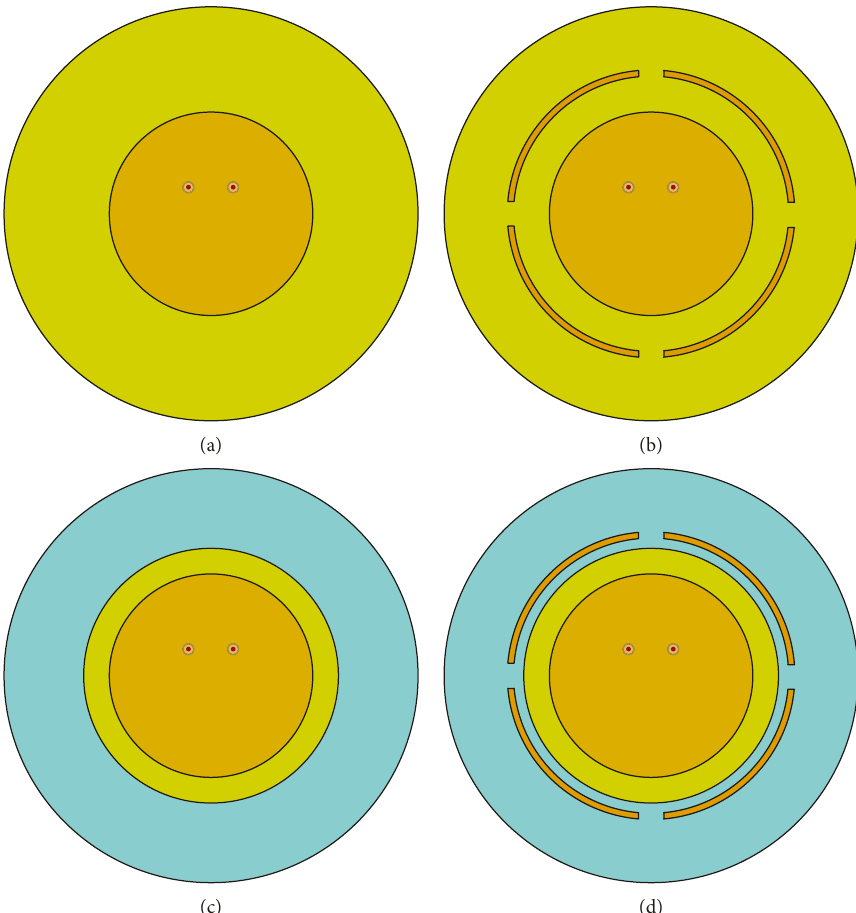
Figure 2: Single-band antenna with four structures. (a) Antenna 1. (b) Antenna 2. (c) Antenna 3. (d) Antenna 4.